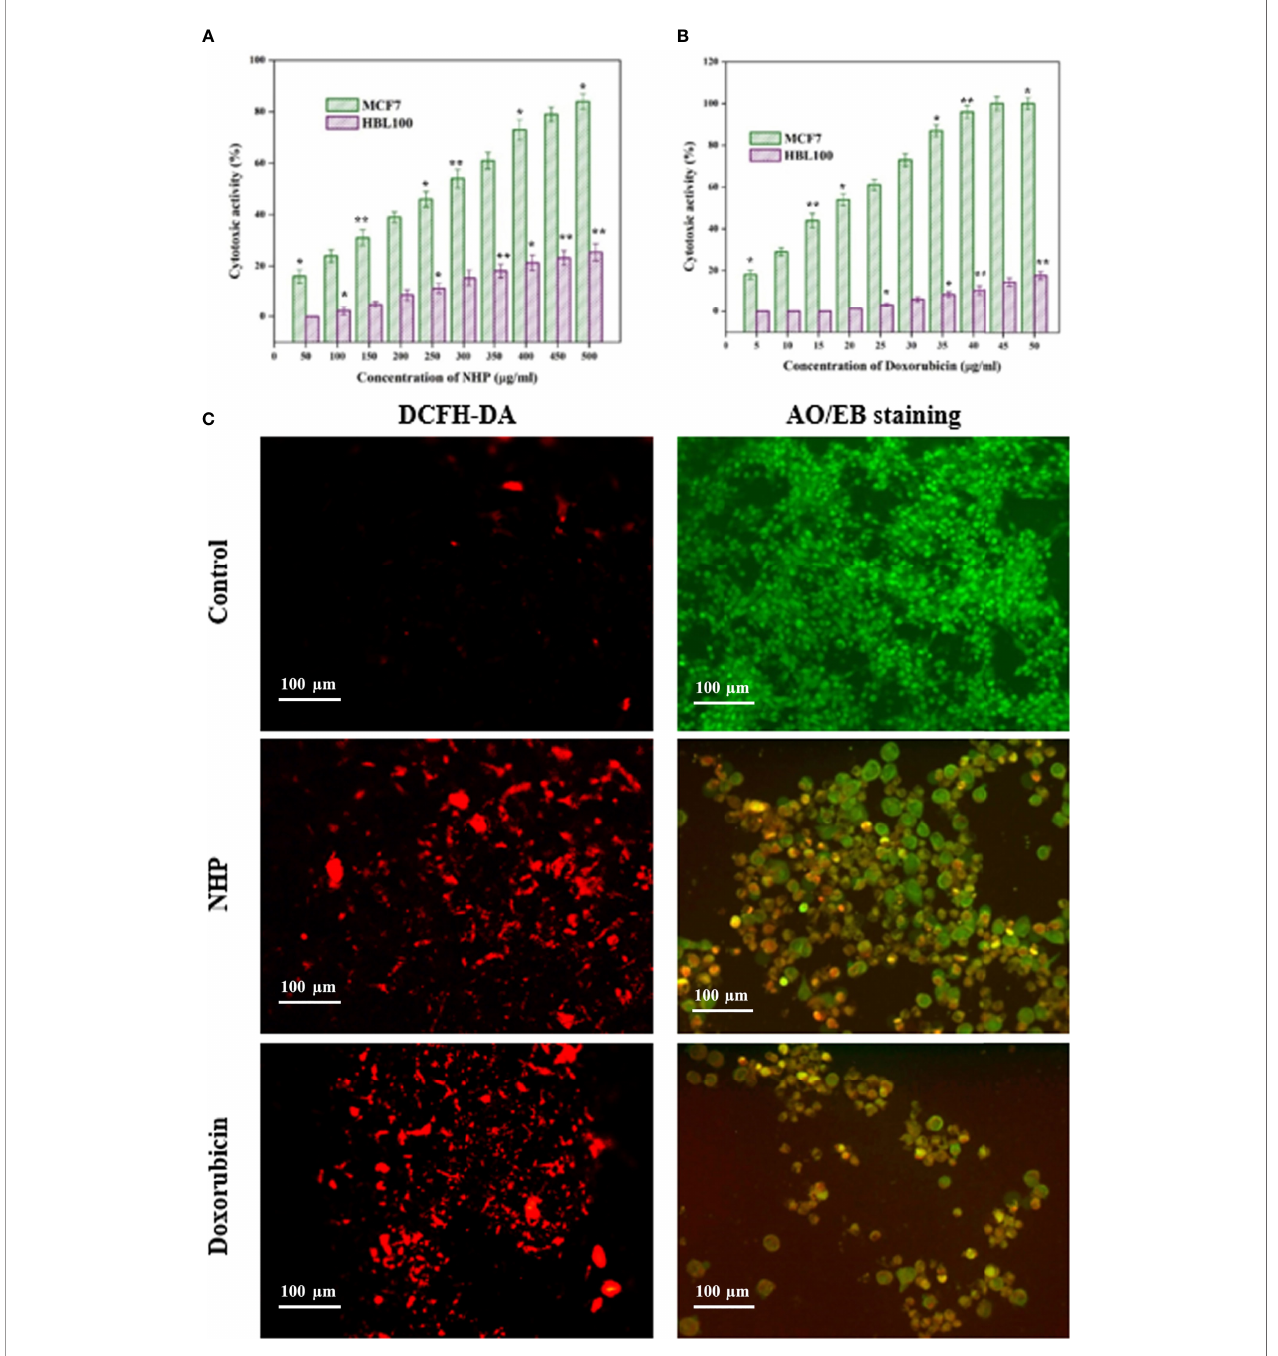
FIGURE 8 | In vitro cytotoxic activity of NHP (A) and doxorubicin (B) against MCF7 breast cancer cells and HBL100 normal cells (C) showed the effect of NHP (300 µg/ml) on ROS generation and apoptosis in MCF7 cells using DCFH-DA and AO/EB staining, respectively. The results were taken in triplicates and expressed as mean ± standard deviation and the signi fi cant differences were * p < 0.05 and ** p <